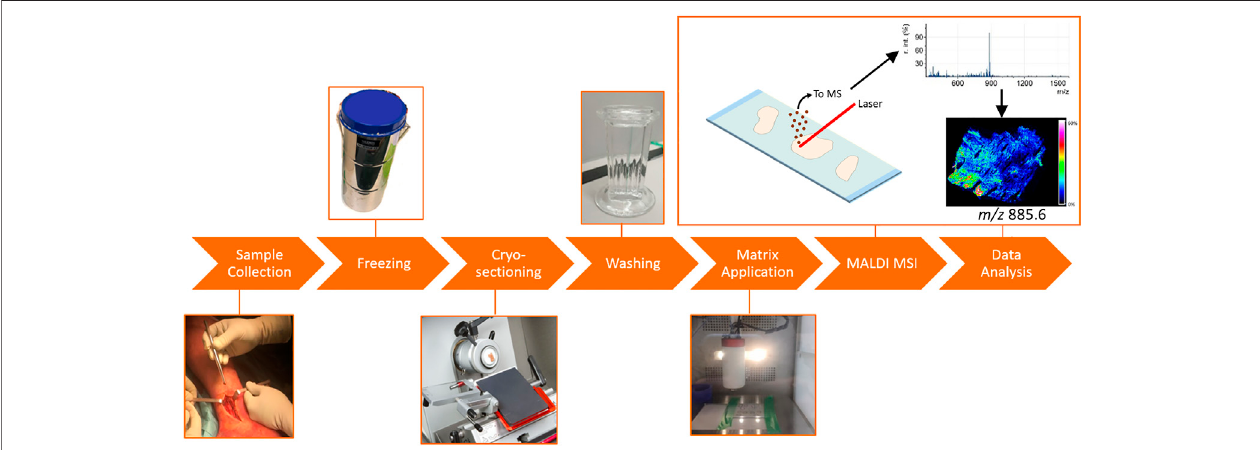
FIGURE 1 | General MALDI-MSI work fl ow, applied to fracture hematoma analysis. The fxh was surgically removed and snap frozen in liquid nitrogen. The fxh was cryo-sectioned and thaw mounted on ITO slides. The slides were washed by submerging them in either ammonium formate or acetone. Afterwards, norharmane was homogenously sprayed onto the slides. The coated slides were analyzed by MALDI-MSI after which the data were processed and visualized.